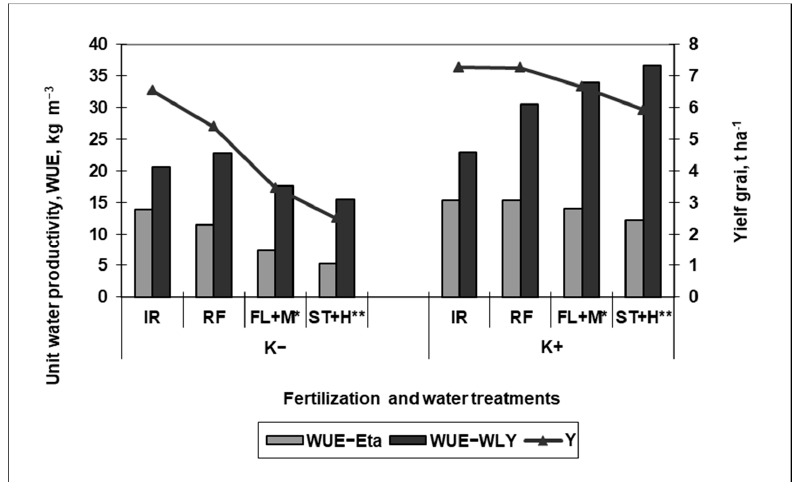
Figure 3. Effect of water treatments and potassium management on indices of water use efficiency (based on [26]. Legend: IR, RF—irrigated and rainfed water treatments; FK+M, ST+H—water shortage imposed at * stem elongation + heading; ** flowering + early milk. WUE—water Use Efficiency; Eta—calculated based on evapotranspiration; WLY—calculated based on FAS approach [33].